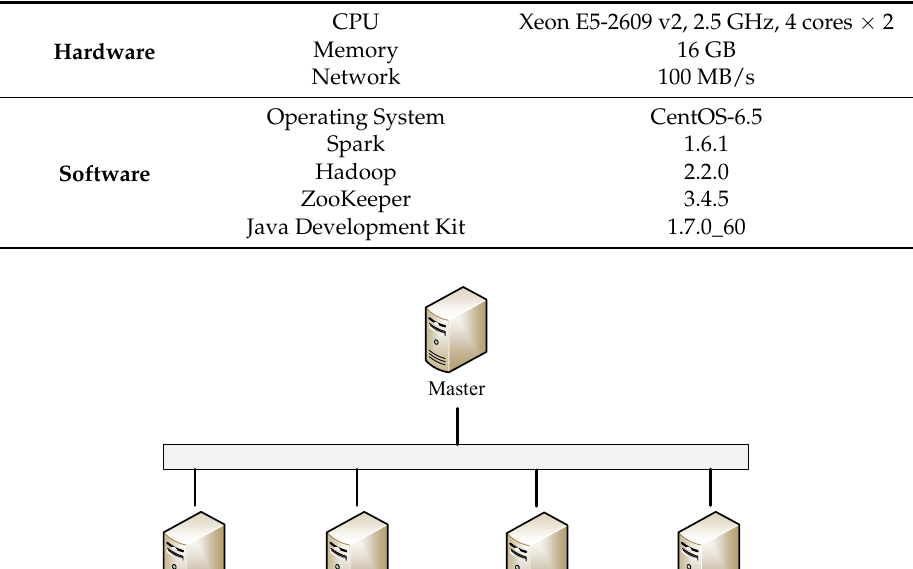
Table 2. Software and hardware configuration.